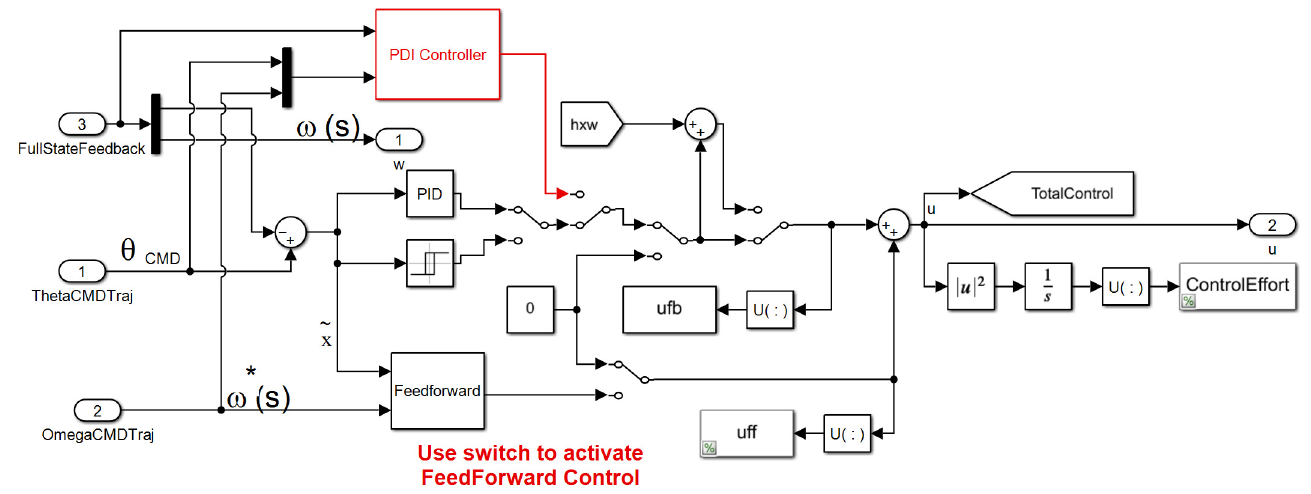
Figure A4. Controllers subsystem in Figure A3. The * indicates optimal values.